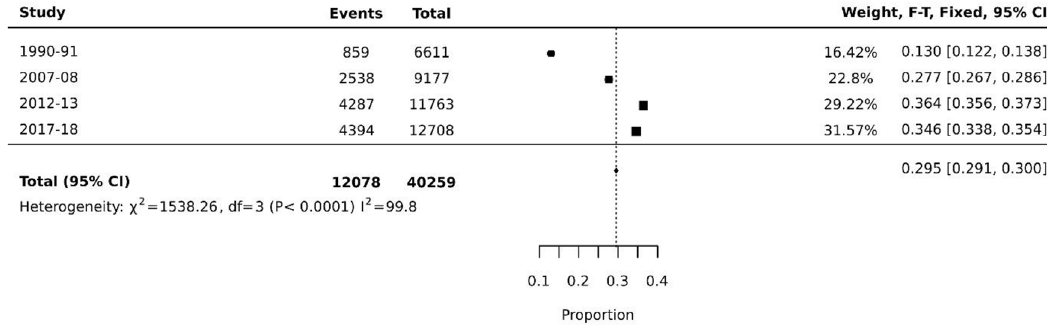
Figure 3. Rates of contraception usage among women of reproductive age group from